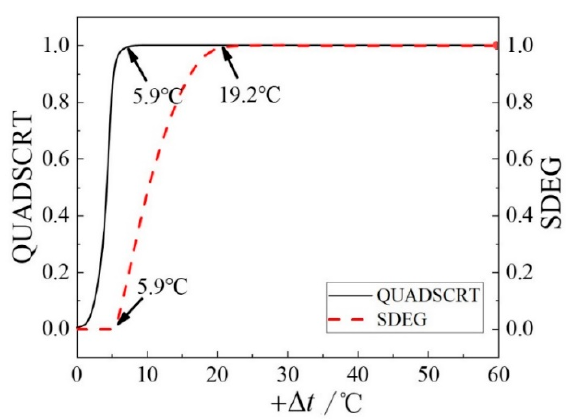
Δ ∆ t . . Figure 8. QUADSCRT and SDEG varying with